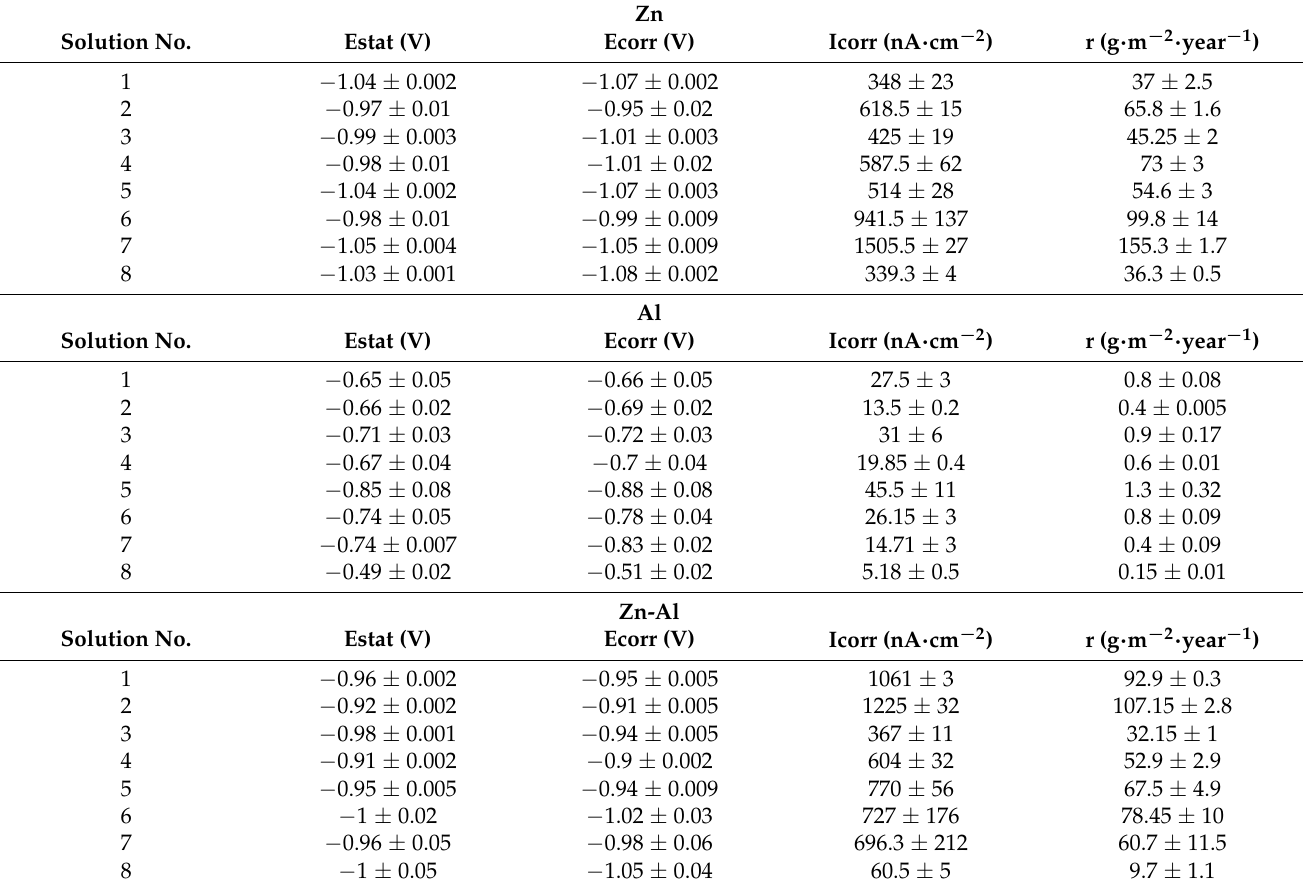
Table 6. Electrochemical properties of arc sprayed Zn, Al, and Zn-Al coatings in solutions.